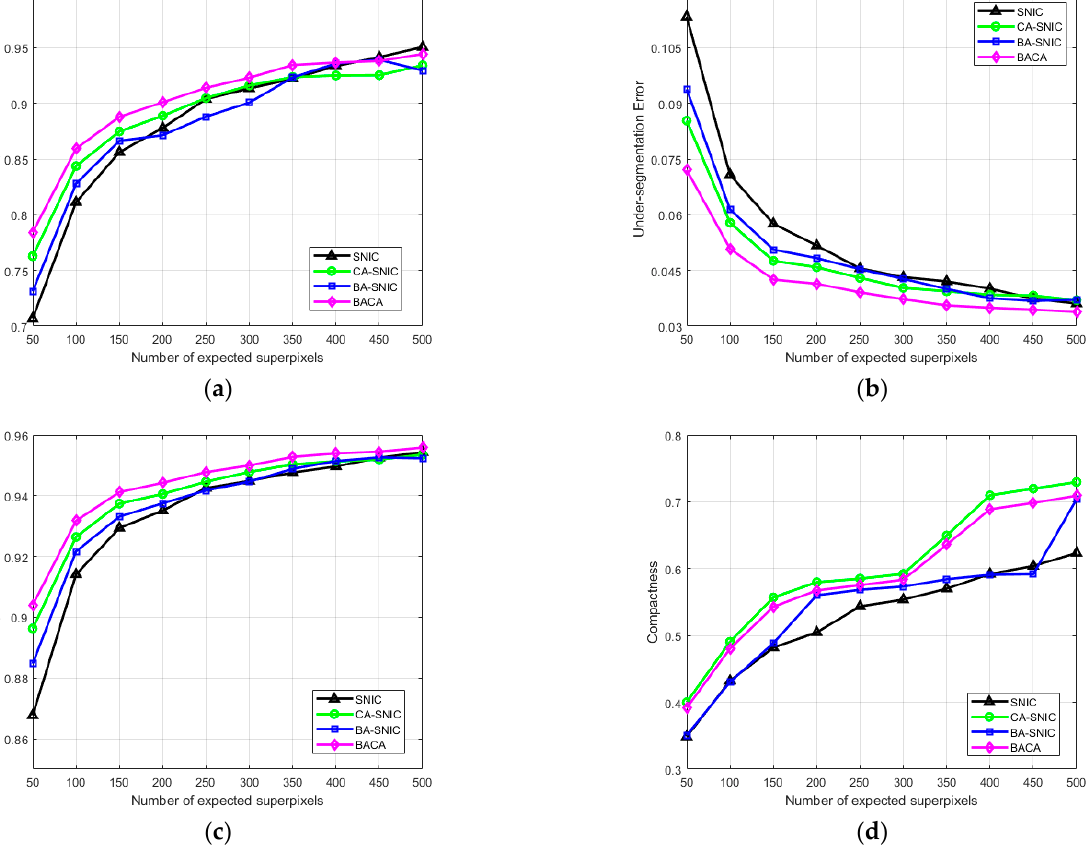
Figure 11. Quantitative evaluation of different algorithms on four evaluation indicators. ( a ) Boundary recall; ( b ) Under-segmentation error; ( c ) Achievable segmentation accuracy; ( d ) Compactness. The expected number of superpixels ranges from 50 to